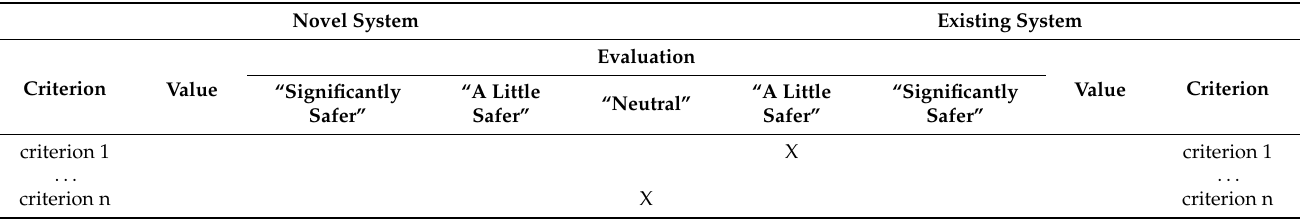
Table 4. Comparison table.